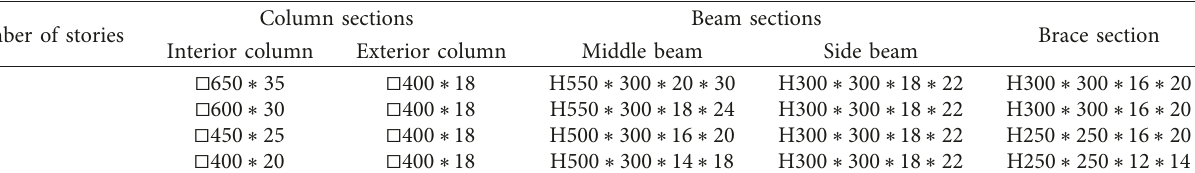
Table 5: Member sections of 10-story V-EBF.